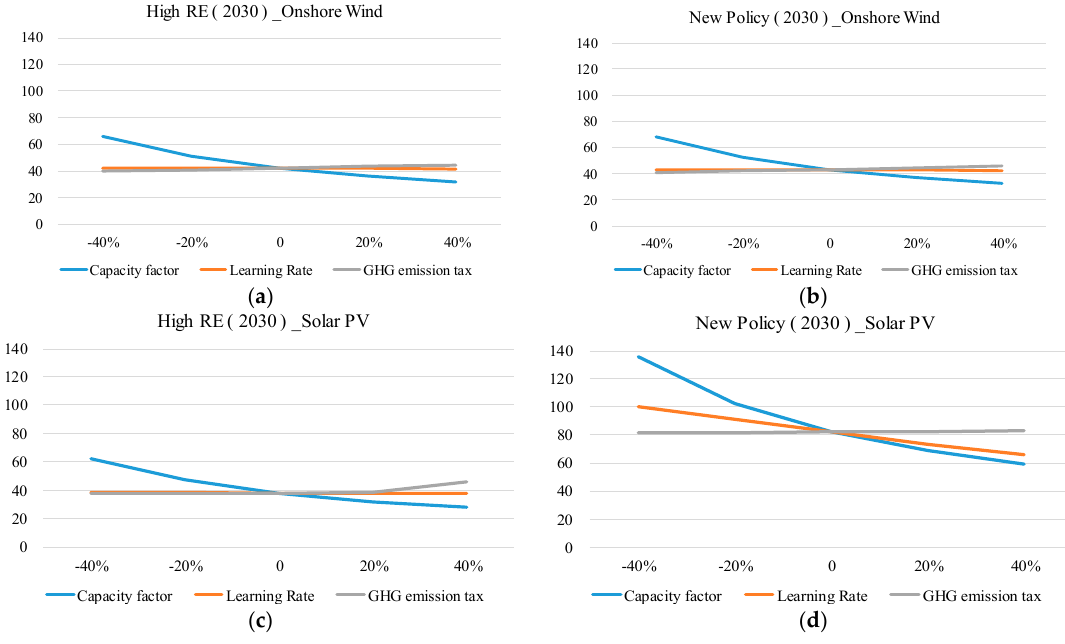
Figure 3. LCOE ($/KWh) sensitivity analysis of onshore wind and solar PV in the “high renewable energy penetration scenario” (ERI& NDRC) and “New Policies” (IEA) scenario. ( a ) High RE on shore wind; ( b ) New policy onshore wind; ( c ) High RE solar PV; and ( d ) New policy solar PV